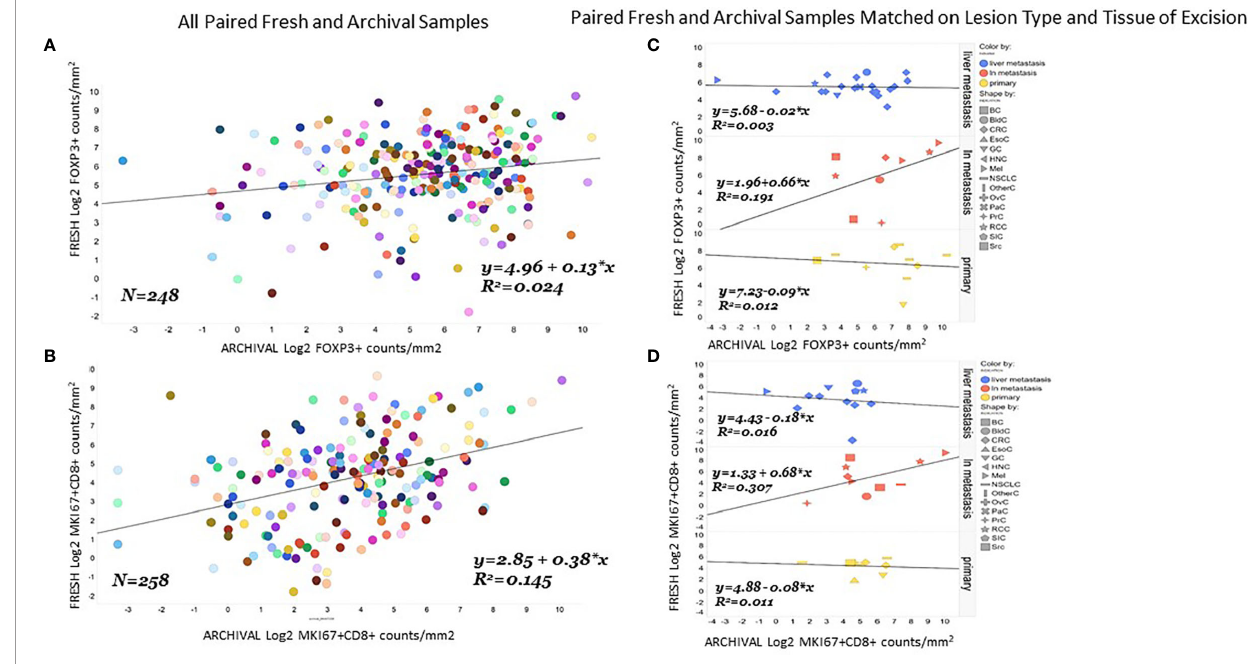
FIGURE 3 | Correlation of FoxP3+ or MKi67CD8+ levels in fresh and archival tissue from the same patient strongest in lymph node metastases. Correlation and linear regression lines were calculated for FoxP3+ (A) or MKi67+CD8+ (B) levels in all paired archival (X-Axis) and fresh (Y-axis) tissue from the same patient. The same analysis was repeated in paired fresh and archival samples that also matched on tissue of excision and lesion type (C, D)